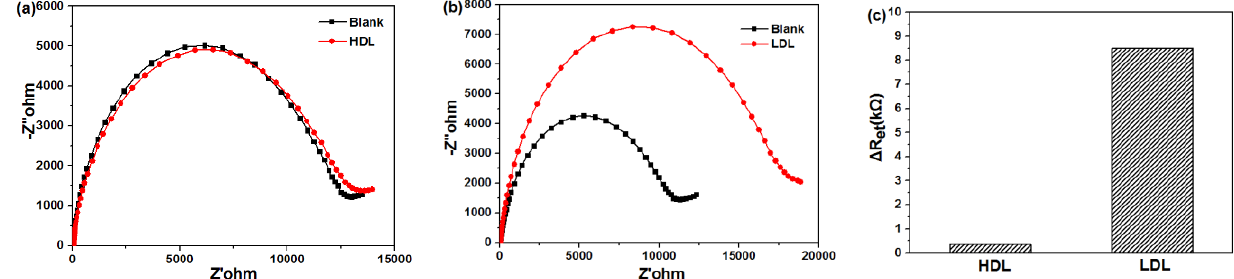
Figure 6. Faradaic impedance spectra that corresponded to the fabricated sensor at 25 °C, before and after incubating with same concentrations of ( a ) HDL, 20 μ g/mL or ( b ) LDL, 20 μ g/mL in PBS (50 mM, pH 7.0) solution containing 0.1 M KCl and 5 mM K 3 [Fe(CN) 6 ]/K 4 [Fe(CN) 6 ]; ( c ) ΔRet of different lipoprotein calculated to faradaic impedance spectra.